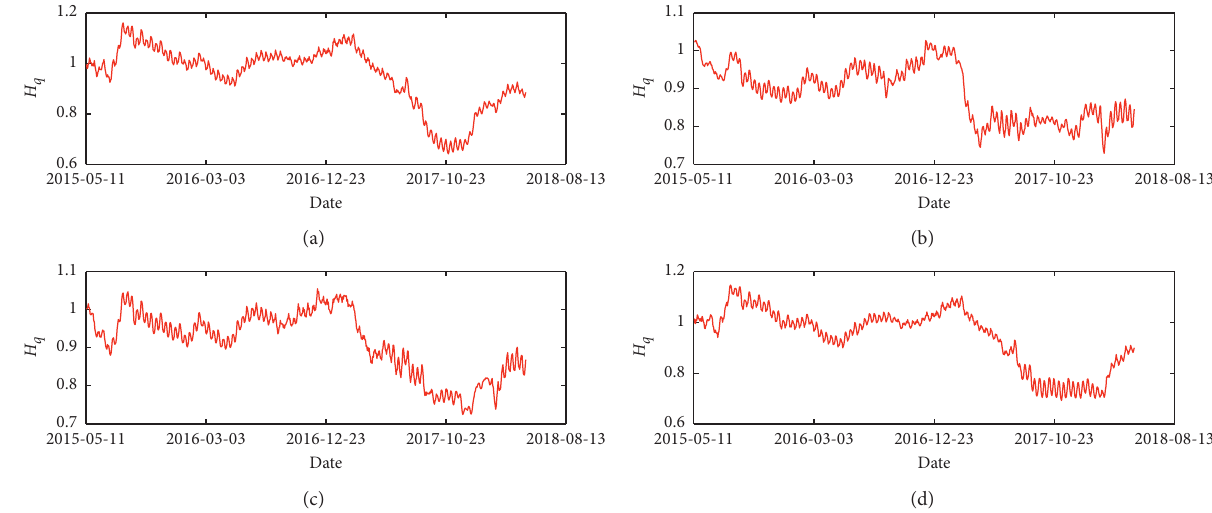
Figure 16: The time-varying scaling exponents for Chinese stock market volatility and market participation willingness when window size is 250 days. (a) SME-YSI. (b) SSE50-YSI. (c) CSI300-YSI. (d) GEM-YSI.